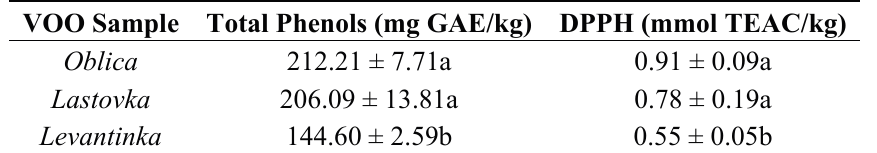
Table 4. Total phenolic amounts and DPPH assay for antioxidant activities of the hydrophilic fractions of Oblica , Lastovka and Levantinka